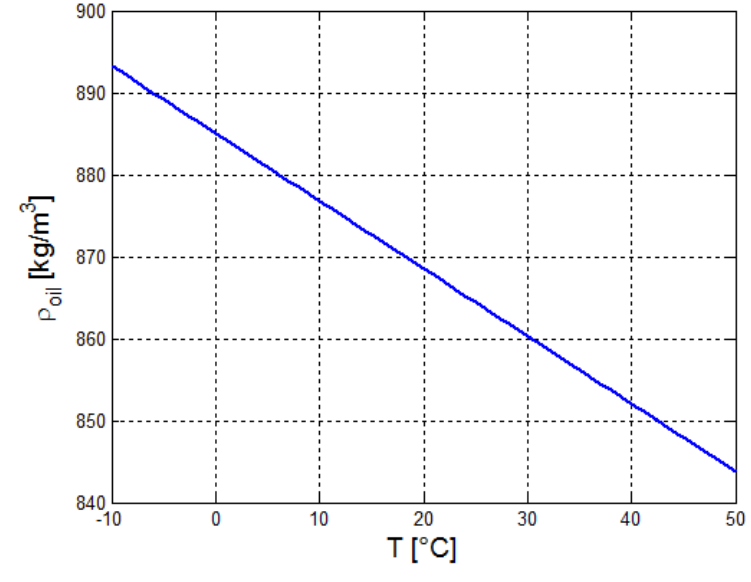
Figure 8. The density of liquid crude oil.